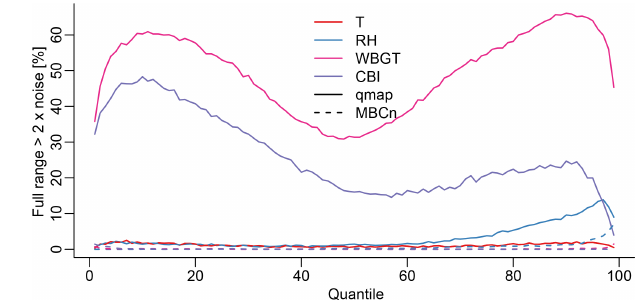
Figure 9. Fraction of grid points for which the full range is at least twice the range of the noise (uncertainty associated with inter- nal variability) in the perfect model approach. Solid lines represent cases computed with UQM; dashed lines represent cases computed with